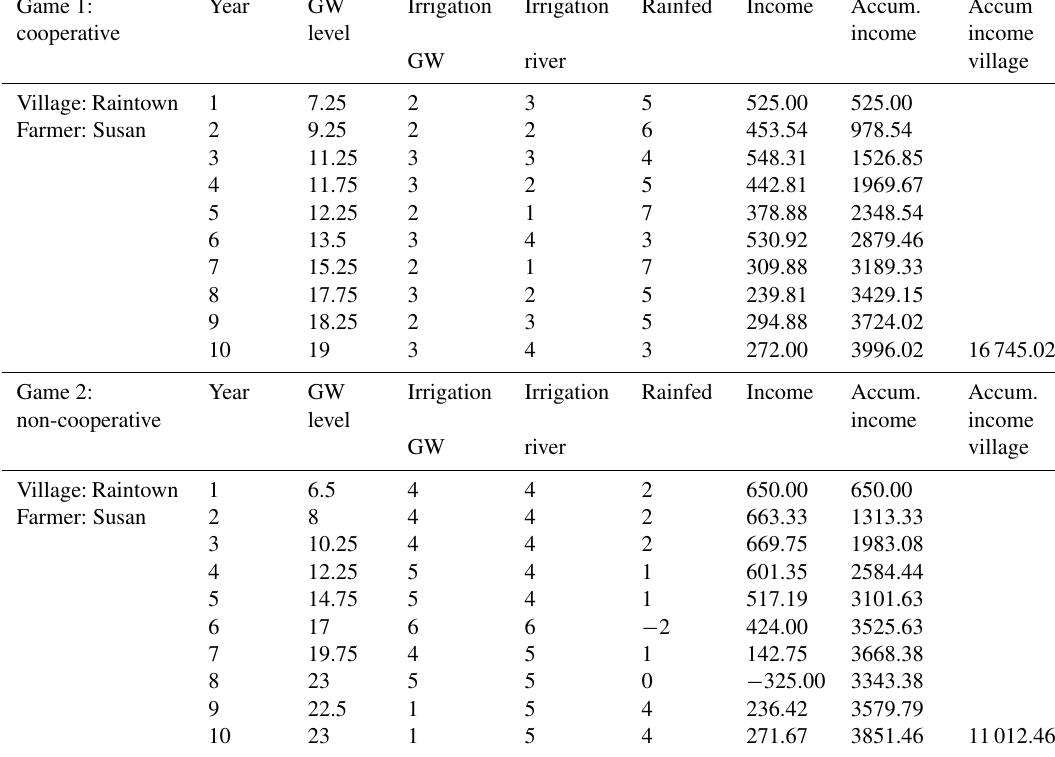
Table 1. Two Irrigania game scenarios played with international students during a course at CABI (Centre for Agriculture and Biosciences International), Delemont, Switzerland: Game 1 (top), a cooperative game, and Game 2 (bottom), a non-cooperative game, for farmer Susan in the village of Raintown. Farmer Susan tends to irrigate more heavily in Game 2, acting more selfishly, ending up with a lower individual income and a lower accumulated income for her village, as compared to Game 1 where the other farmers in Raintown are known to